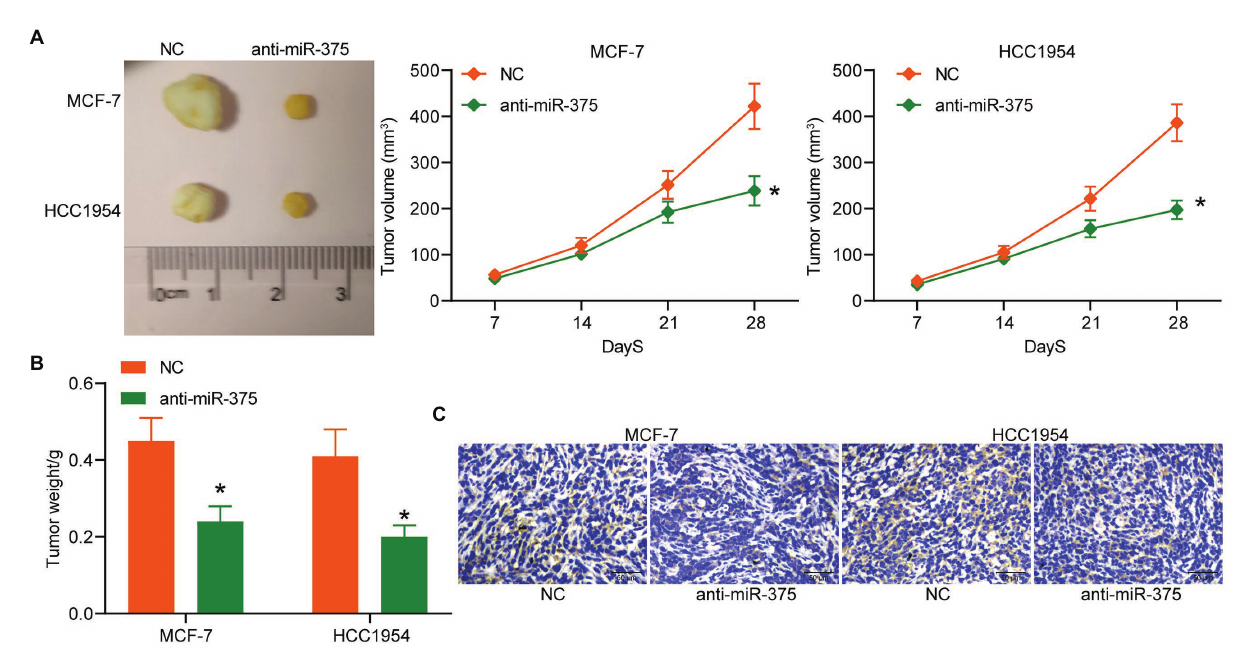
FIGURE 3 | Anti-miR-375 suppresses growth of xenograft tumors in vivo . (A) The picture of the collected tumors and the growth rate of tumors (* p < 0.05, two-way ANOVA); (B) weight of the tumors on the 28th day (* p < 0.05, two-way ANOVA); (C) Ki-67 expression in the tumor sections determined by IHC staining from three independent experiments and exhibited as mean ± standard deviation (SD). Data were presented as mean ± SD from three independent experiments. n = 3 in each